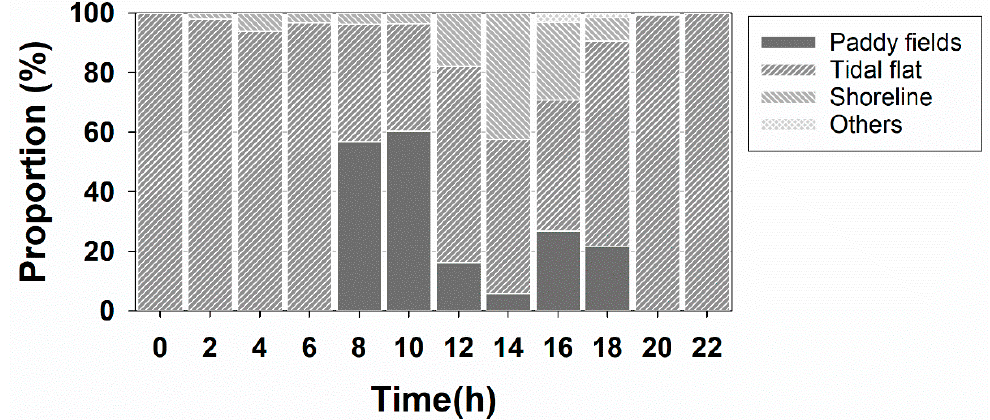
Figure 3. Proportion of habitat use for Swan Goose at two-hour intervals.